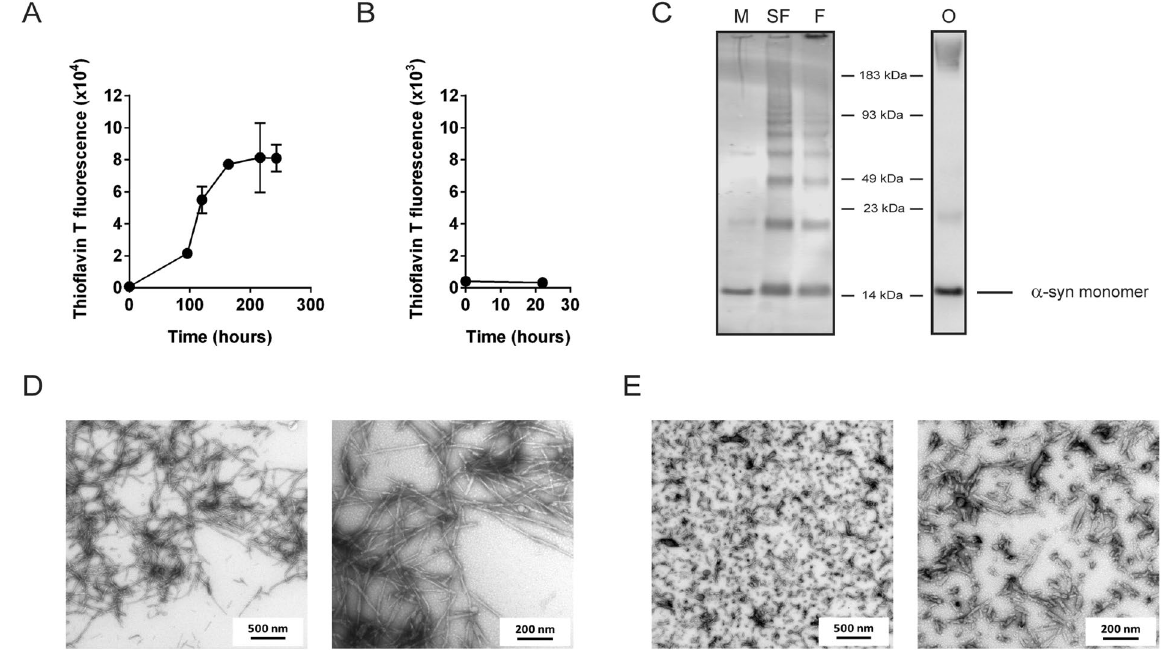
Figure 1. Characterization of α -synuclein aggregates. ( A ) Amyloid fibril formation was followed by a Thioflavin T fluorescence assay. Fibril formation was stopped after 10 days, when the Thioflavin T fluorescence had reached its plateau. ( B ) The oligomeric preparation showed no increase in Thioflavin T fluorescence. ( C ) Western blot analysis of α -synuclein preparations using an anti-synuclein antibody (FL-140, Santa Cruz). M = Monomers, SF = Sonicated fibrils, F = Fibrils, without sonication, O = Oligomers. ( D , E ) Electron microscopy on the fibril preparation showed typical amyloid fibrils ( D ) that broke into shorter fibrils after sonication ( E